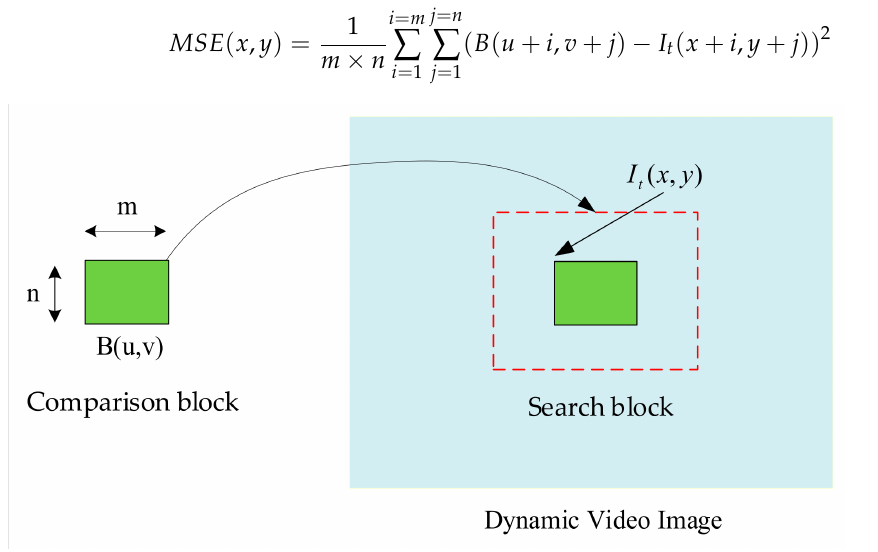
Figure 5. Improved region-based comparative search